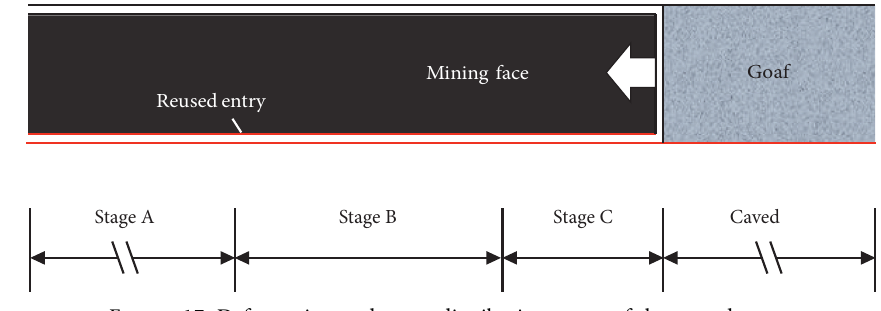
Figure 17: Deformation and stress distribution zones of the reused